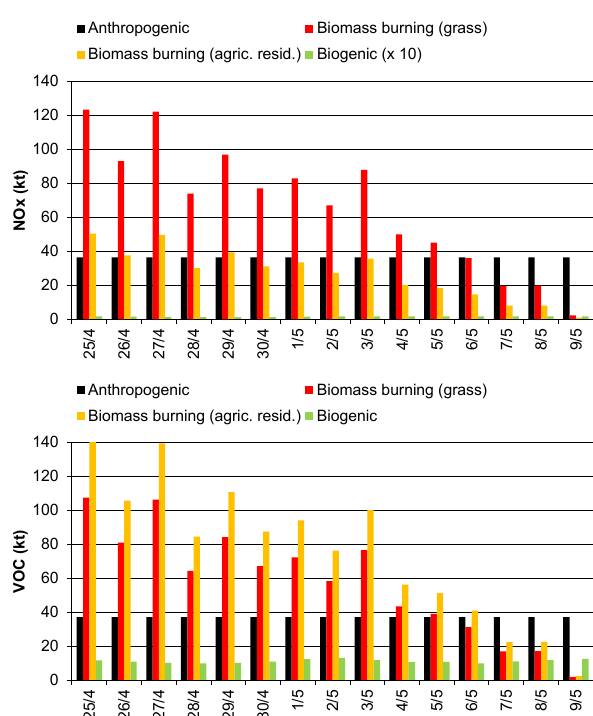
Fig. 4. Anthropogenic, biomass burning (grass and agricultural residues) and biogenic NO x and NMVOC emissions released over Europe during the simulation